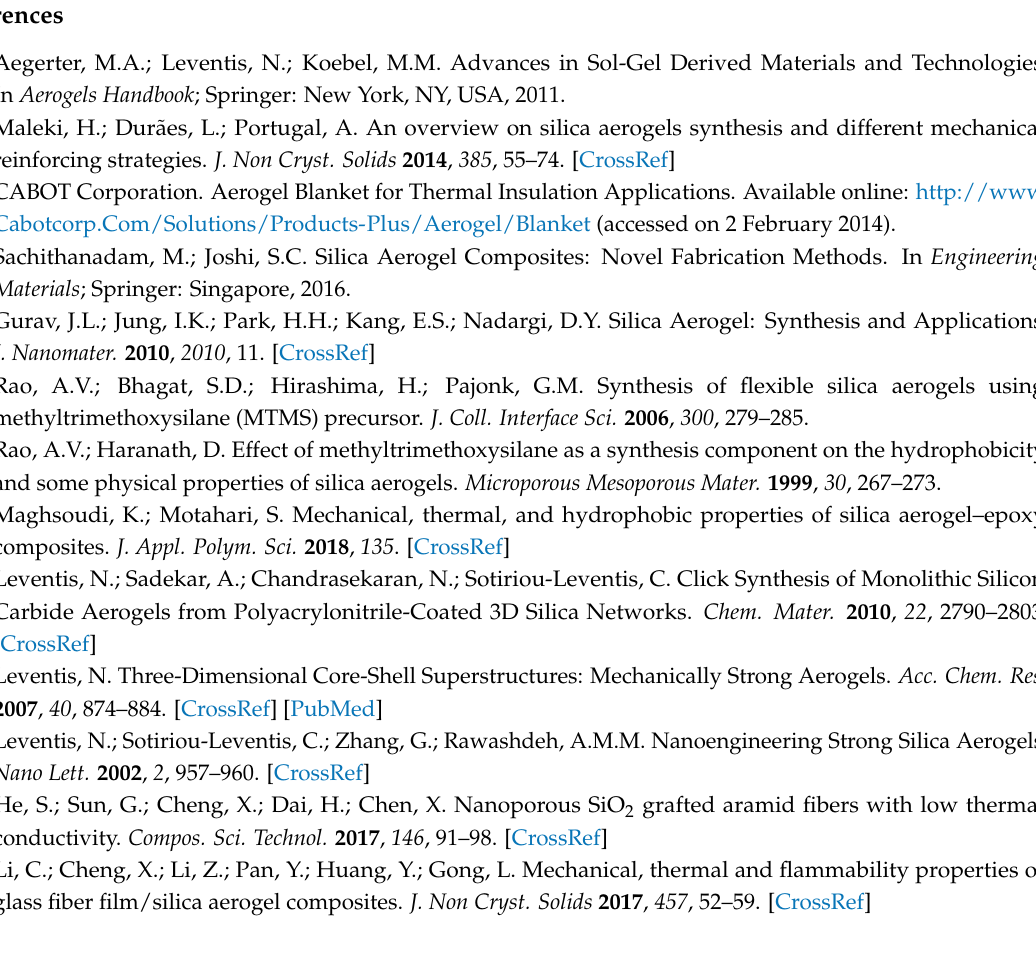
Figure 10. Mechanical characterization test ( a ) Compression test ( b ) Three-point flexure test.